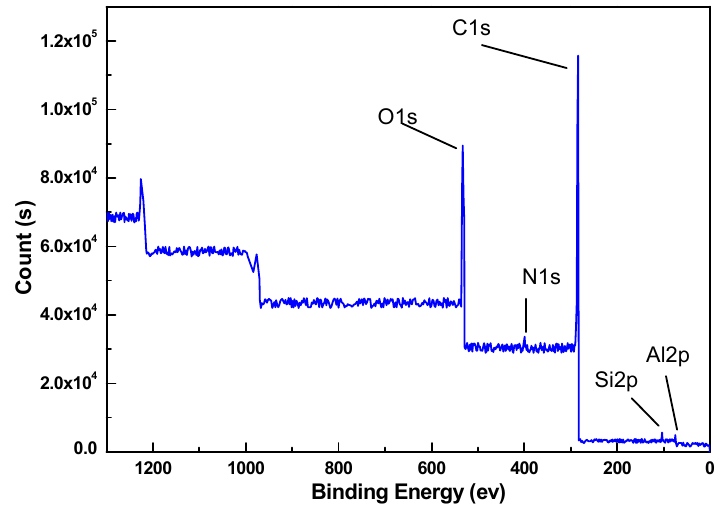
Figure 3. XPS wide-energy spectra of the coal samples.